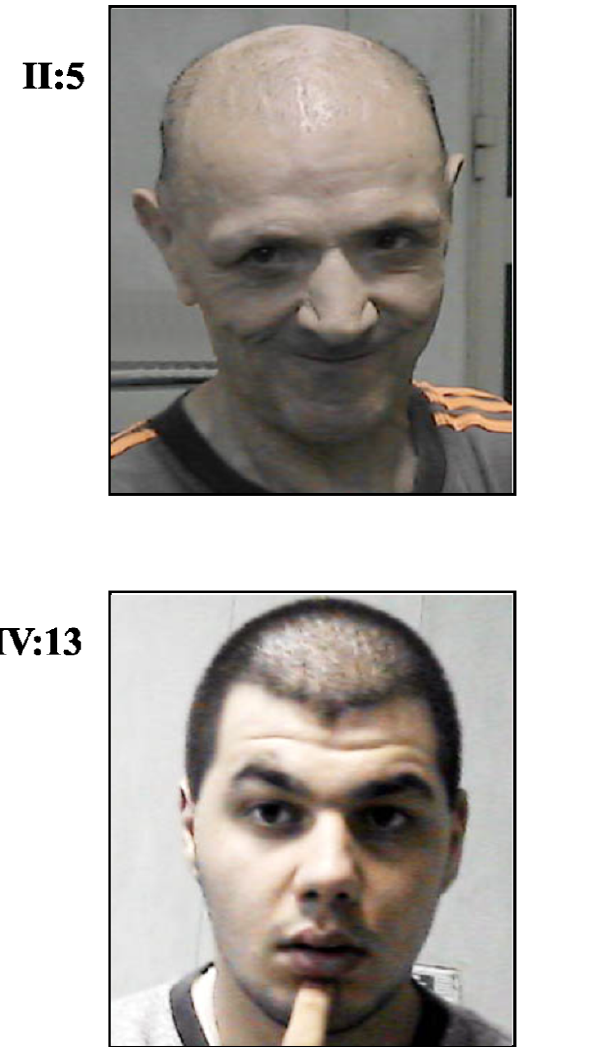
Figure 2 Affected men of MRX87 family with c.428_451dup24 in ARX gene. No consistent facial features are present among the patients.